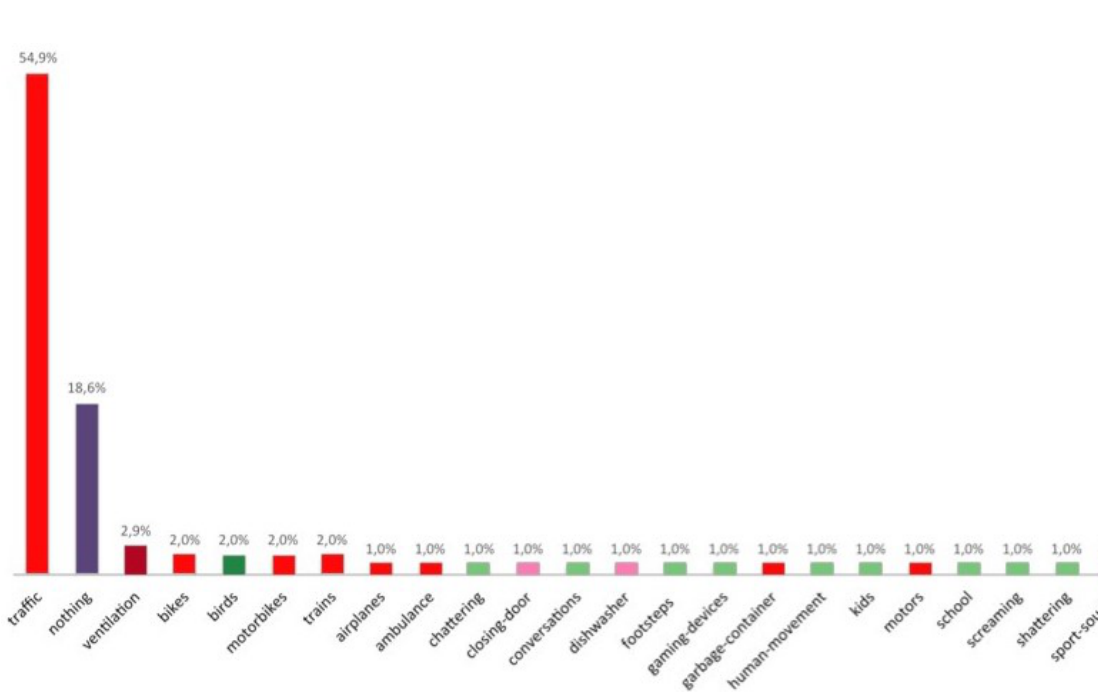
The initial evaluation of data collected in